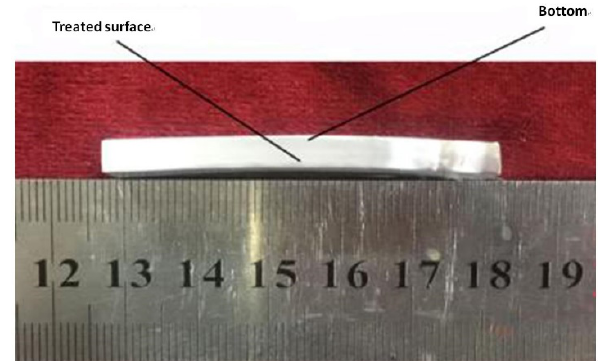
Figure 11. Sketch map of microstructure.